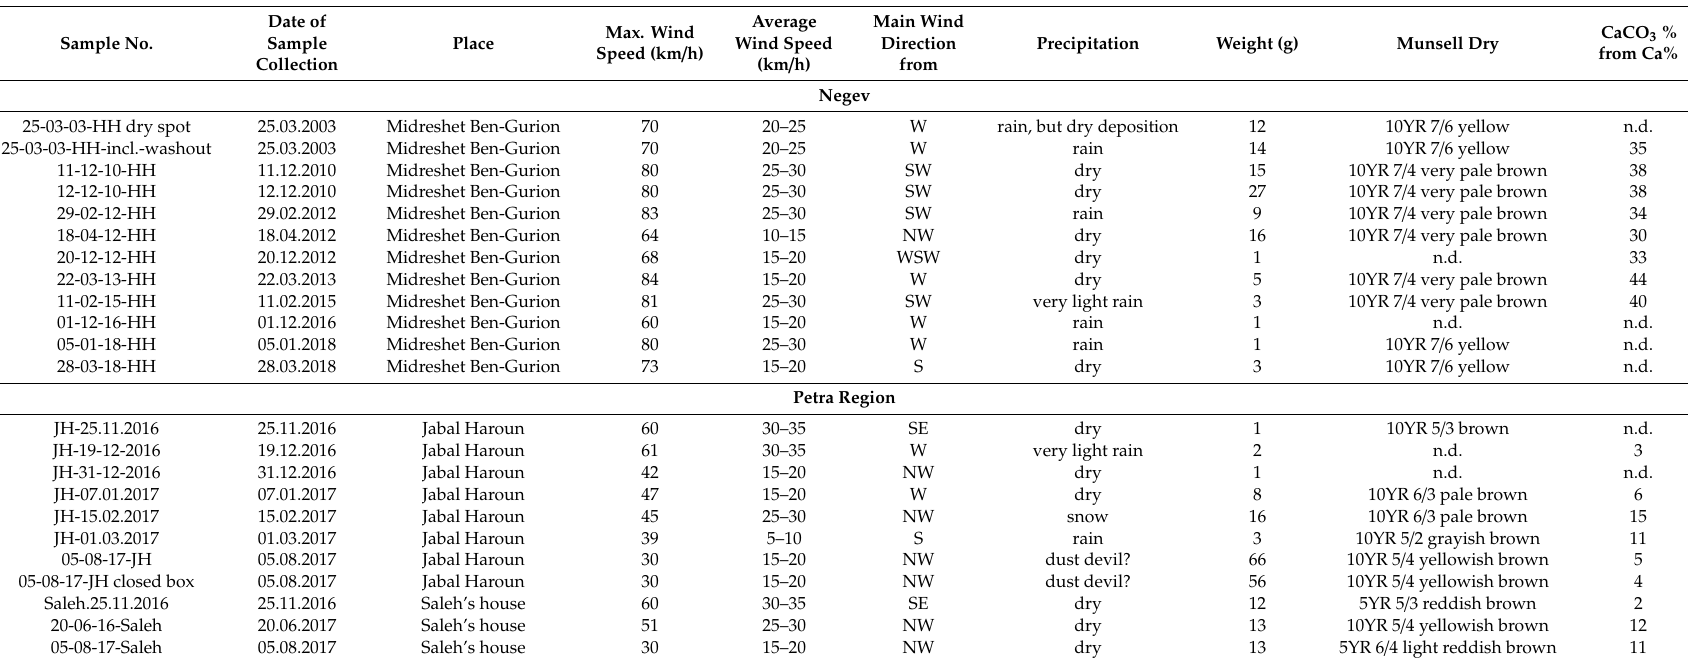
Table 6. List of the collected dust samples, sampling dates and places, collected weights, colors, CaCO 3 contents (estimated from Ca %), and prevailing weather conditions from the Israel Meteorological Service (https: // ims.data.gov.il / ) for Sede Boker, and from ventusky.com and field observations in the Petra region. Sample